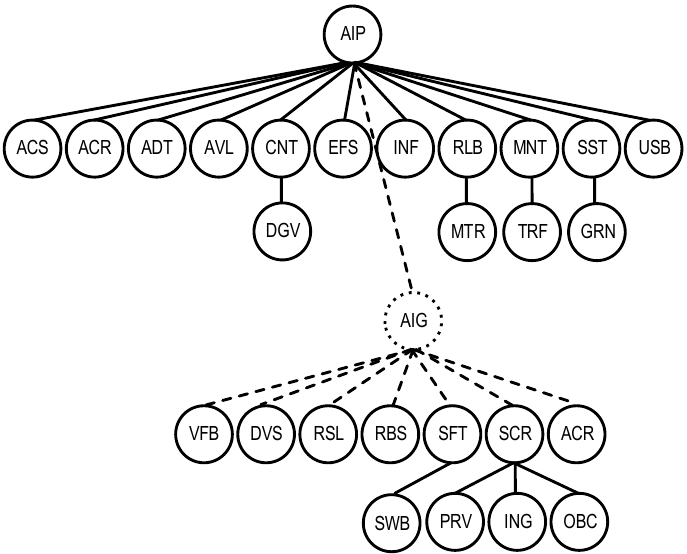
Figure 5. The graph representation of the AI platform quality model 𝑄𝑆 𝐶ℎ𝐴𝐼𝑃 .